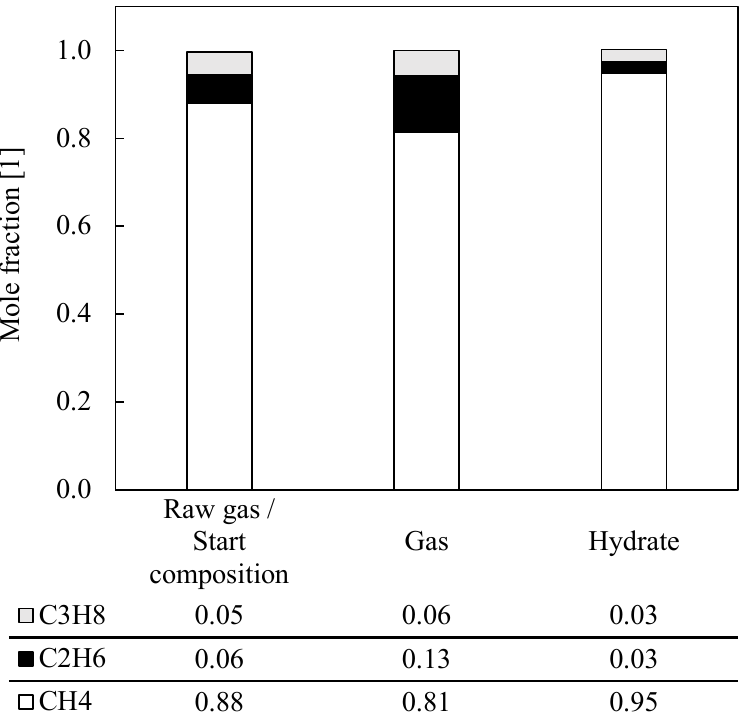
Figure 4. Averaged mole fractions of a synthetic natural gas as a measure of the change in composition due to gas hydrate formation; database: see Table 2, Measurement Series 14–16; left column: raw gas composition; middle column: remaining gas composition after one-stage rapid hydrate formation; right column: corresponding gas composition in hydrate phase, measured after decompo- sition.